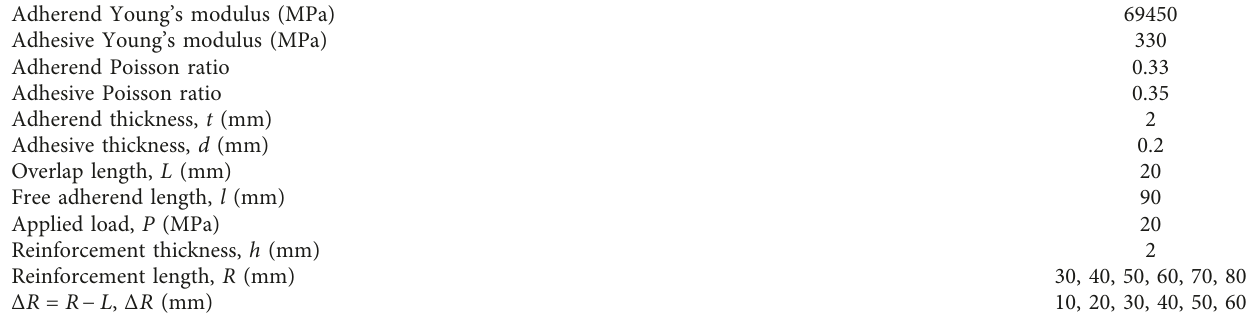
Table 1: Material parameters and single-lap geometry.